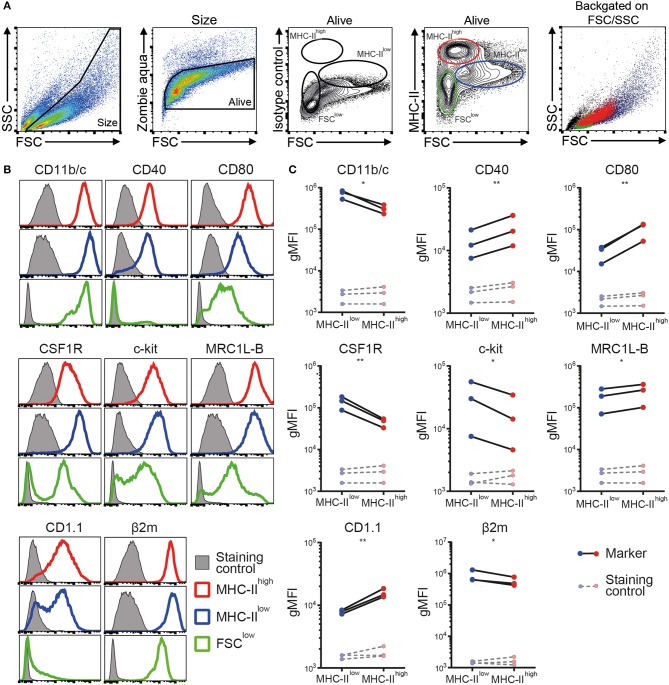
Phenotypic analysis of chicken bone marrow-derived dendritic cells (chBMDCs) shows the presence of different subpopulations. (A) The cells were gated, respectively, for their scatter profile [forward scatter (FSC)/side scatter (SSC)], viability (Zombie Aqua), and expression of major histocompatibility complex class II (MHC-II), as shown in the first, second, and fourth panels. The third panel shows the signal after staining the cells with an isotype control antibody that corresponds to the antibody against MHC-II. Three subpopulations were selected based on FSC and MHC-II expression: FSClow MHC-II−/low (green), FSCint MHC-IIhigh (red), and FSChigh MHC-IIlow (blue). The last panel shows the scatter profiles of the different subsets in matched colors, which were overlaid on the first panel. (B) Expression levels of a set of phenotypic markers are shown by representative histograms for the three subpopulations in corresponding colors. Each marker addressed was stained with a combination of either unconjugated primary antibody and allophycocyanin (APC)-conjugated secondary antibody or biotinylated primary antibody and APC-conjugated streptavidin. Filled gray histograms represent cells that have been stained with APC-conjugated streptavidin or secondary antibody to show the background fluorescence. (C) For the MHC-IIlow and MHC-IIhigh subpopulations, the expression levels of all phenotypic markers are expressed as the geometric mean fluorescent intensity (gMFI) for three independent replicates. The gray dashed lines represent corresponding controls that have been stained with APC-conjugated streptavidin or secondary antibody alone. Statistically significant differences between chBMDC subsets are shown/indicated by *p < 0.05 and **p < 0.01.